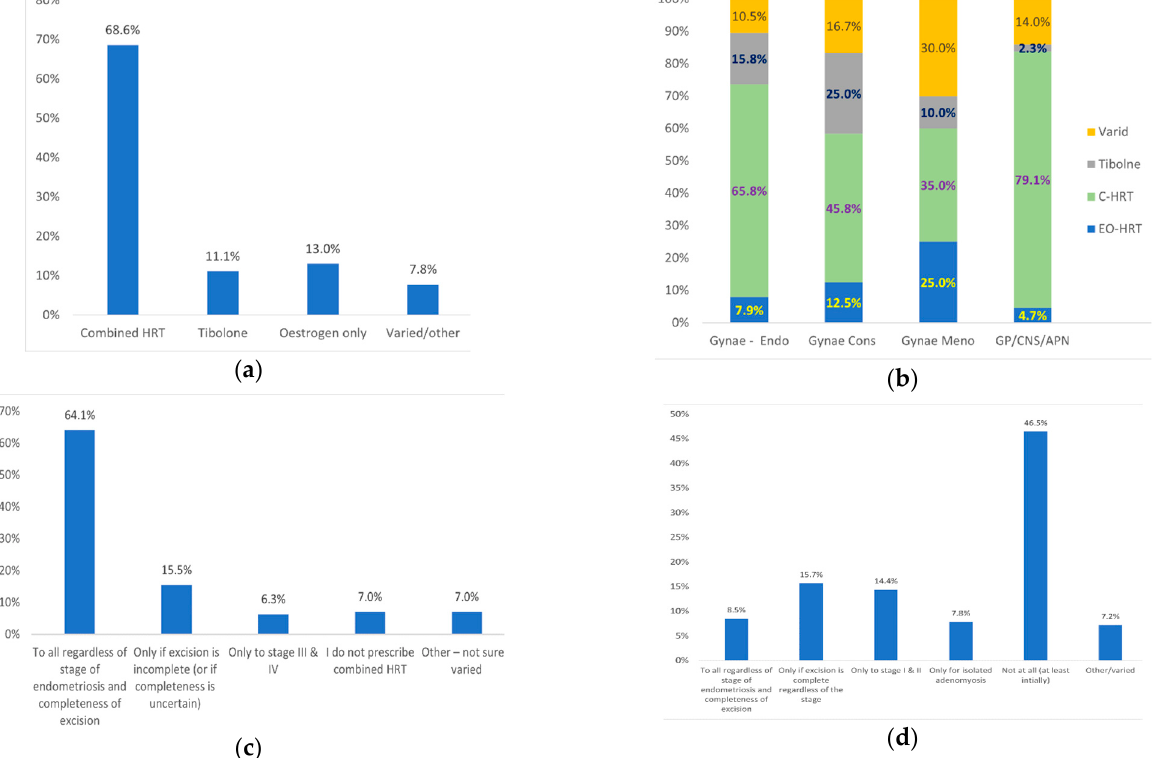
Figure 5. Type of HRT prescribed ( a ) Overall percentages of responders prescribing different types of HRT; ( b ) Percentages of responders of different grades prescribing different types of HRT; ( c ) Percentages of responders prscribing combined HRT according to endometriosis severity or completeness of excision; ( d ) Percentages of responders prescribing oestrogen only HRT according to endometriosis severity or completeness of excision. Abbreviations: Gynae, Gynaecology; Endo, Endometriosis Specialist; Cons, Consultant; Meno, Menopause specialist; GP, General Practitioners; CNS, Clinical Nurse Specialist; APN, Advanced Nurse Practi ti oner.